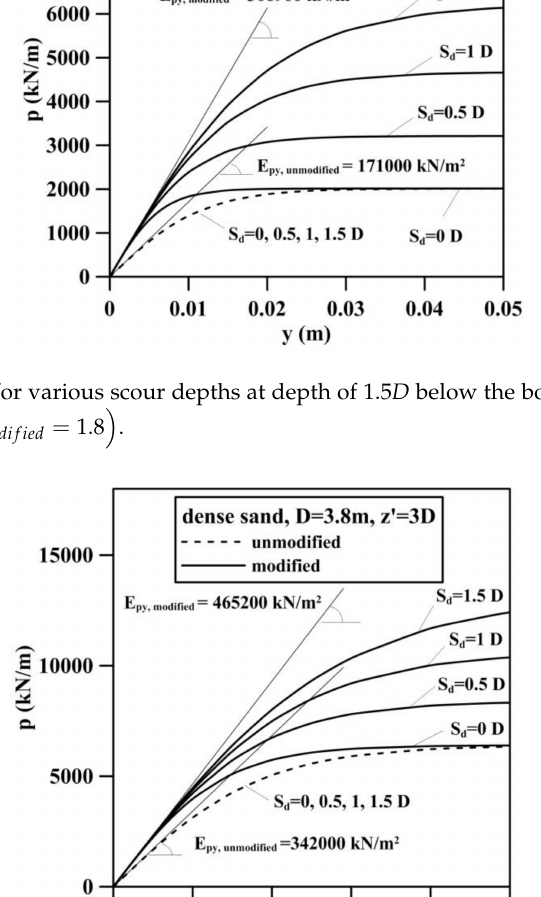
Figure 13. p – y curves for various scour depths at depth of 3 D below the bottom of the scour hole. (cid:16) (cid:17) E py , modified / E py , unmodified = 1.4